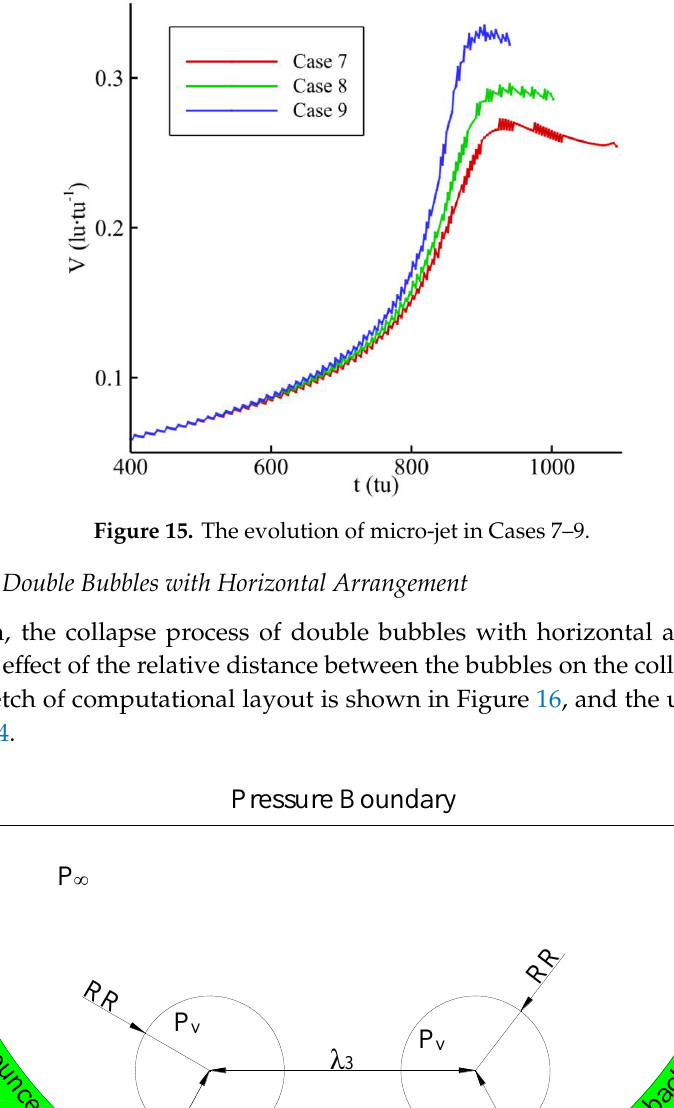
Figure 14. The evolution of pressure at point P in Cases 7–9.